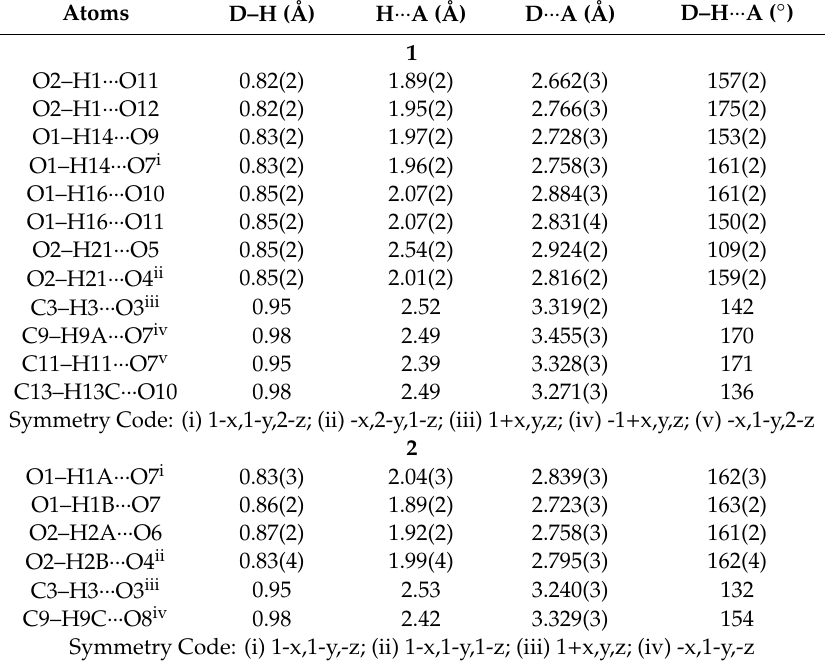
Figure 3. Important H–bond contacts in 1 and 2 . The green and blue colored contacts refer to the C–H ··· O and O–H ··· O interactions, respectively. Table 3. The Geometric parameters of the H–bonds in 1 and 2 .